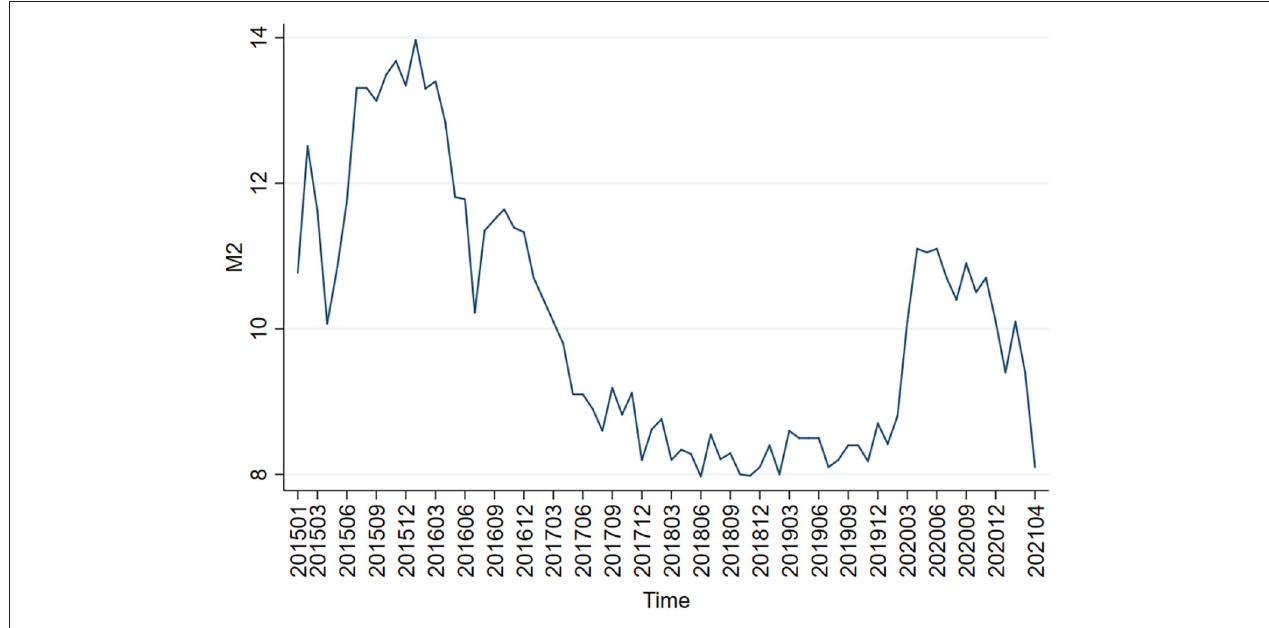
FIGURE 1 | Trend chart of the QOQ-EOP M2 stock real growth rate.